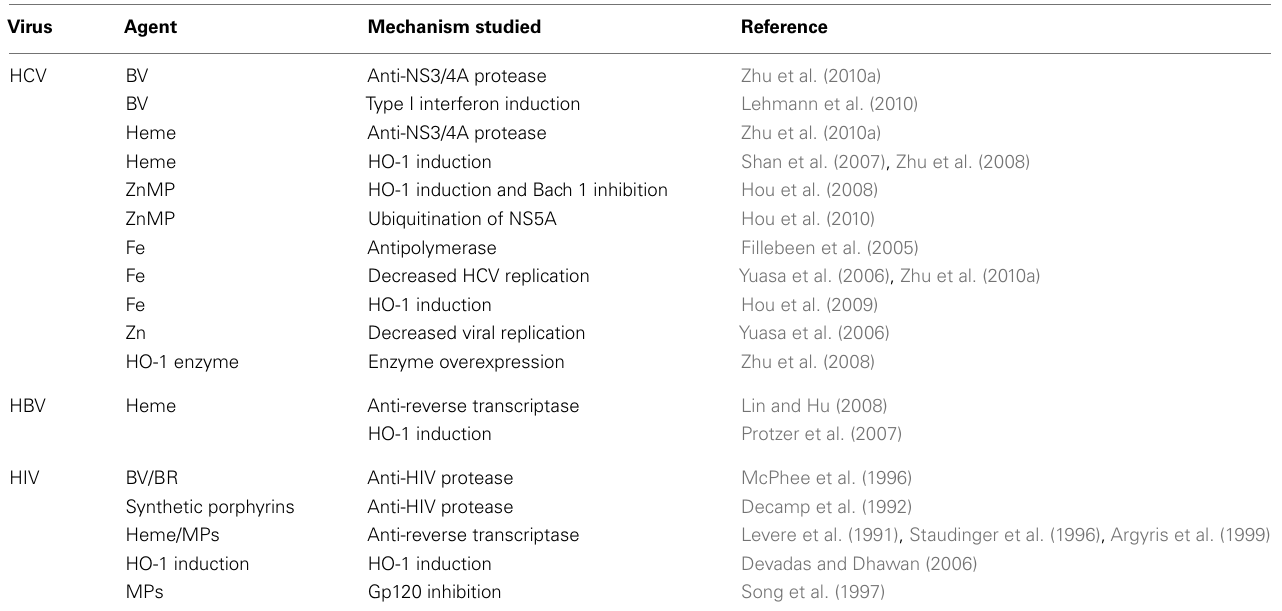
Table 1 |Activities of heme and related agents for HCV, HBV, and